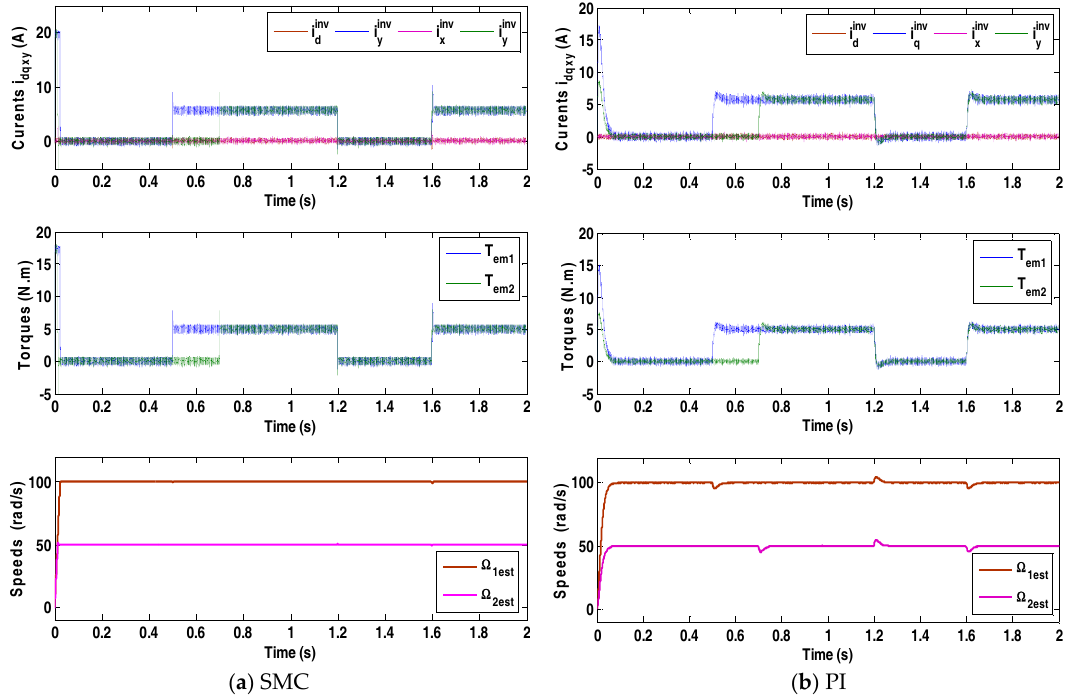
Figure 10. Dynamic responses of parallel-connected two five-phase PMSMs system at different loading conditions.